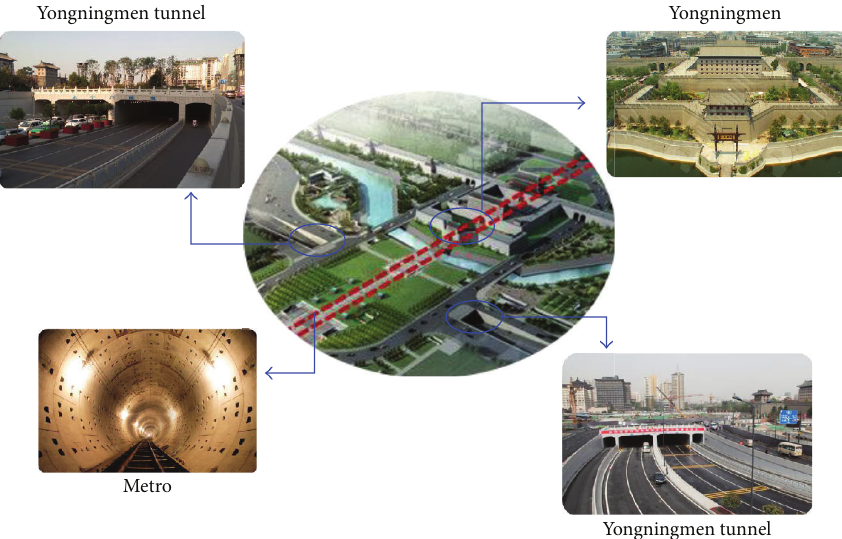
Figure 1: The location of the Yongningmen tunnel and Metro Line